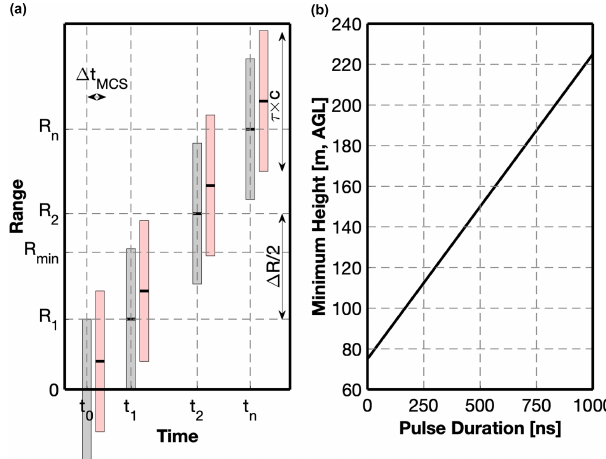
Figure 11. The theoretical minimum range of a DIAL system. Panel (a) shows the relationship between time and range. The gray bars’ total height represents the laser pulse’s length. The adjoining red pulse represents the shift in range during the photon accumu- lation time. Panel (b) shows the minimum range achievable as a function of pulse length for an MPD operating with 250ns photon accumulation bin width and (cid:49)R =